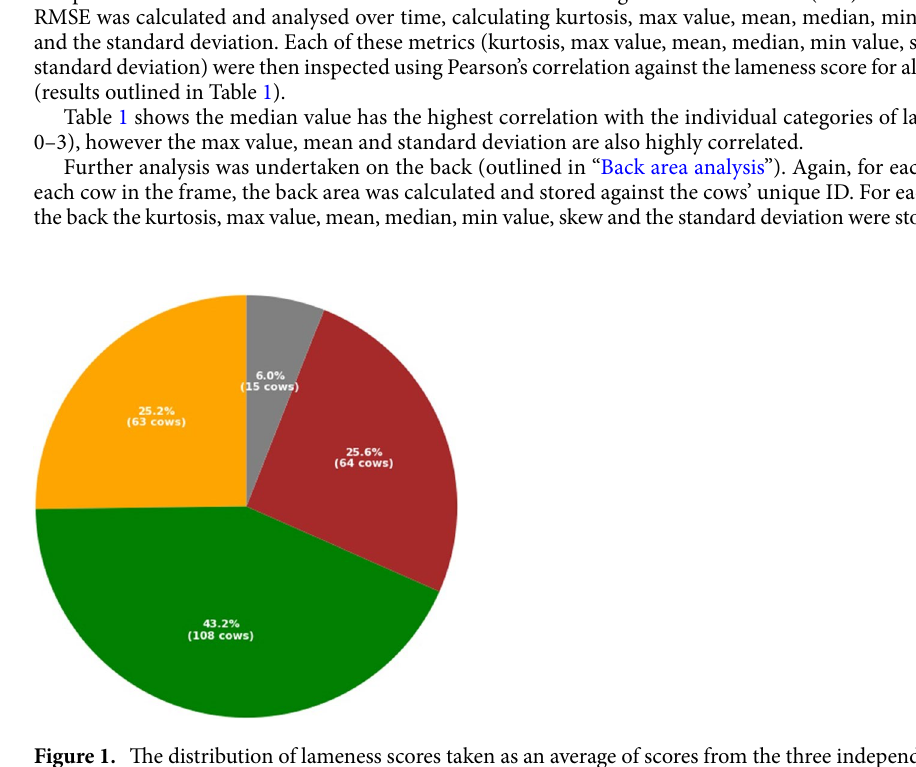
Figure 1. The distribution of lameness scores taken as an average of scores from the three independent registered accredited mobility scorers. Of the total 250 cows, 25.2% of them were assigned a lameness score of 0 (orange), 43.2% with a lameness score of 1 (green), 25.6% with a lameness score of 2 (red) and 6% with a lameness score of 3